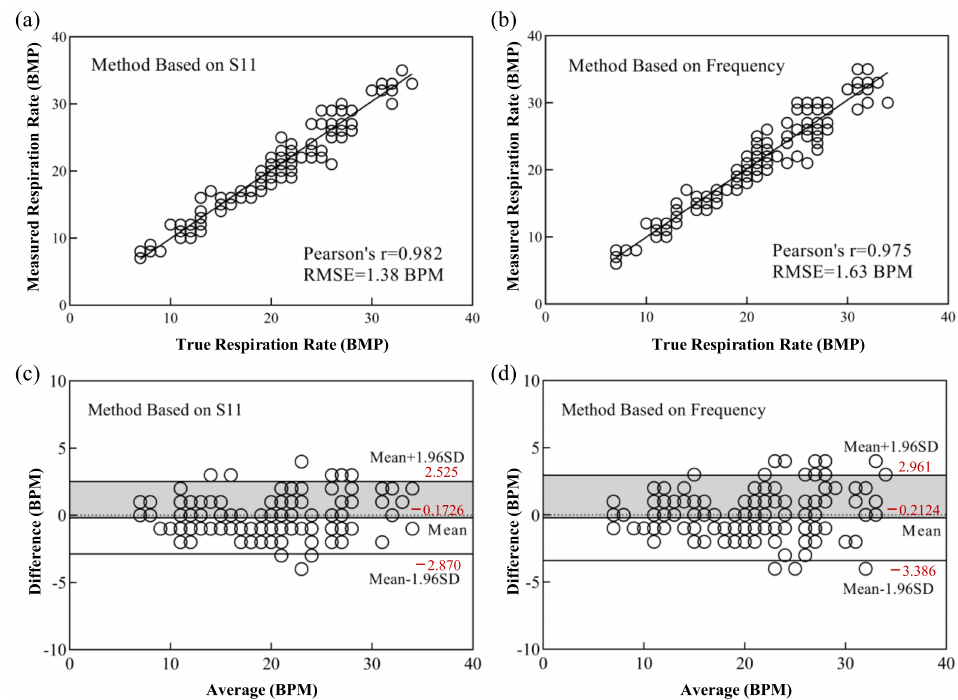
Figure 14. Correlation plots of ( a ) S 11 and ( b ) frequency with clinical monitor test results. Bland– Altman plots of ( c ) S 11 and ( d ) frequency with clinical monitor test